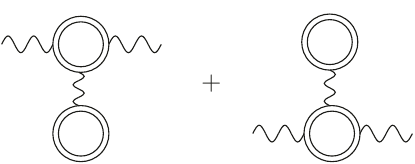
Figure 3 . Tadpole diagrams contributing to the two-loop photon polarization tensor in constant electromagnetic